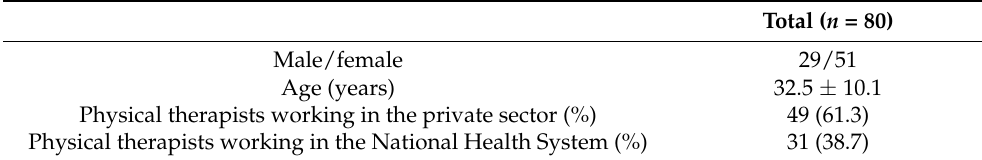
Table 2. Demographic characteristics of